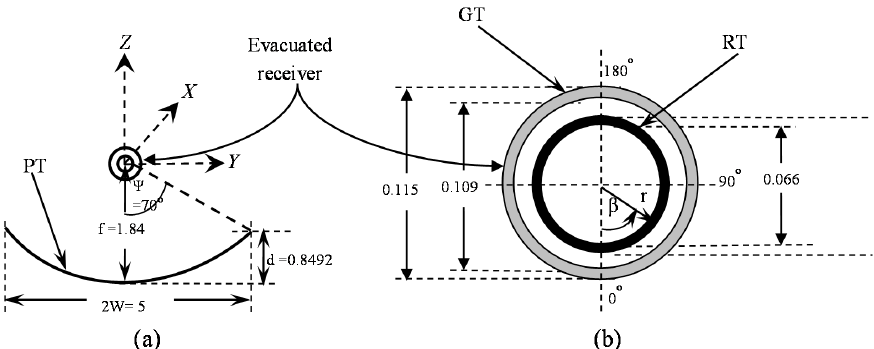
Figure 1. Cross-section of LS2 collector (all linear dimensions are in meter) and the coordinate system used in the ray tracing: ( a ) the Cartesian coordinate system, ( X , Y , Z ) , for the complete collector, and ( b ) the Polar coordinate system, ( X ,r, β ) , for the tubular components such that ( X , Y , Z ) = ( X ,r sin β , − r cos β ) (in the figure, d, f, W and ψ are depth, focal length, half width and rim angle of the mirror, respectively, and the acronyms PT, GT and RT mean Parabolic Trough, Glass Tube and Receiver Tube,